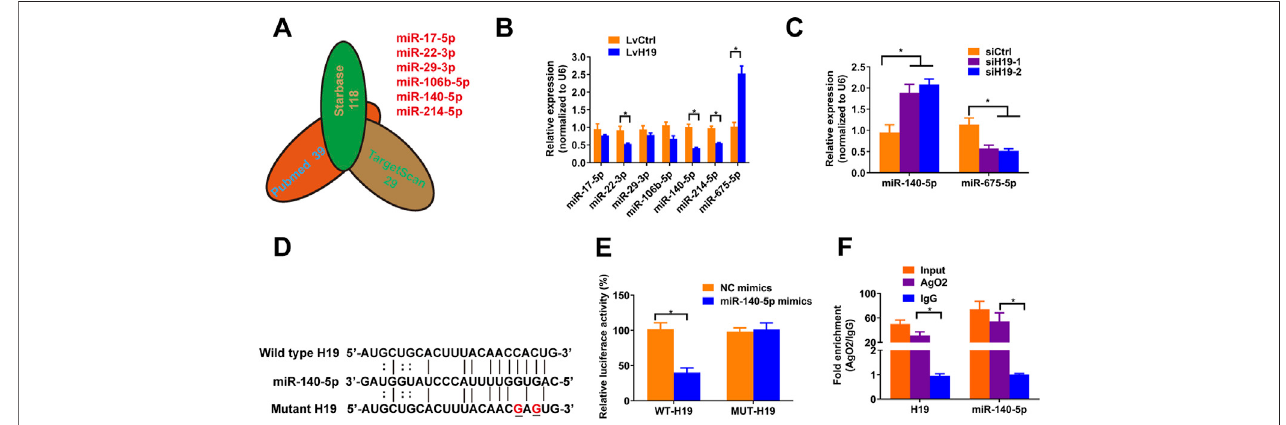
FIGURE 2 | H19 interacts with miR-140-5p. (A) Predication of potential targets of H19 by using of bioinformatic analysis methods starbase and Targetscans in combination with Pubmed database. The number indicated potential miRNAs that may inhibit osteogenic differentiation of VSMC or interact with H19. (B) VSMCs were treated with lentivirus containing full length of H19 cDNA (LvH19) or control cDNA (LvCtrl). qRT-PCR was performed to evaluate expression of miR-17-5p, miR-22-3p, miR-29-3p, miR-106b-5p, miR-140-5p, miR-214-5p, and miR-675-5p in VSMCs transfected with LvH19 or LvCtrl. (C) The expression of H19 in VSMCs after infected with H19 siRNA (siH19) or control siRNA (siCtrl). Expression of miR-140-5p and miR-675-5p were evaluated by qRT-PCR in VSMCs infected with siH19 or siCtrl. (D) Schematic view of miR-140-5p putative target sites in WT and MUT H19 3 ′ -UTR. (E) VSMCs were transfected with luciferase report vector containing WT or MUTH193 ′ -UTRfollowingbytransfectionofmiR-140-5pmimicsorcontrolmimics.Luciferaseactivitywasdetermined48 hposttransfectionandluciferaseactivitywas normalised to Renilla luciferase activity. (F) RIP analysis was performed to evaluate enrichment of H19 and miR-140-5p in Ago2 immunoprecipitates. Each experiment was repeated for three times. The data represent the mean ± SD of triplicates. * p < 0.05.